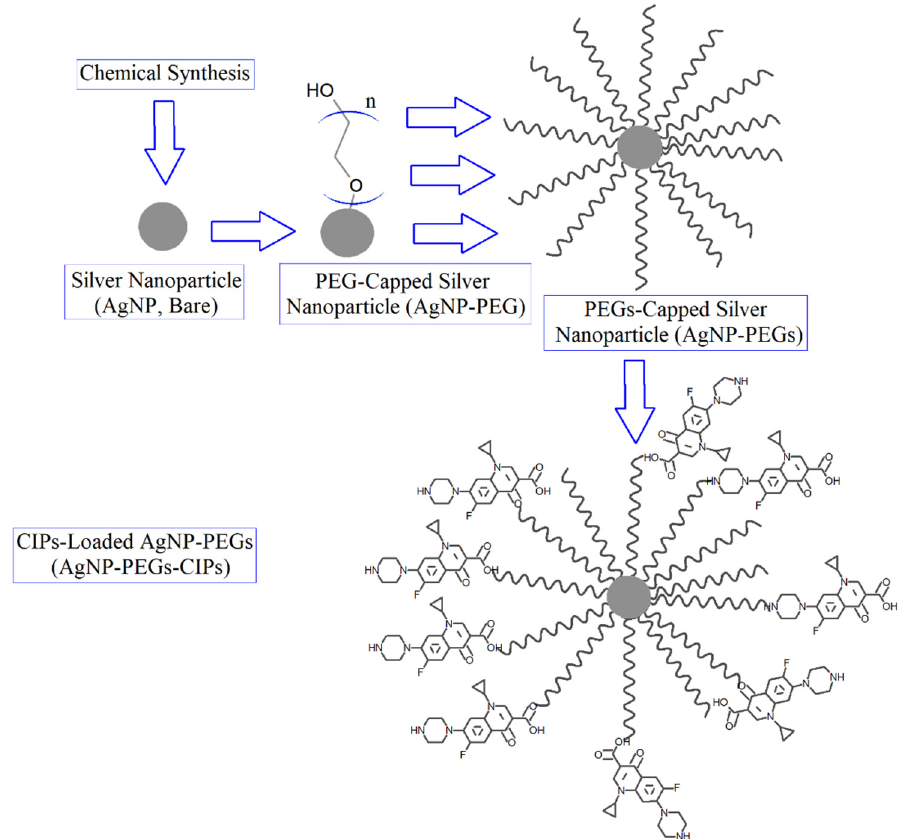
Figure 1. Schematic representation of the AgNP-PEG-CIP preparation and the molecular interaction sites (OH, NH, (C=O)-OH, and C=O) between the PEGs and the CIP molecules.